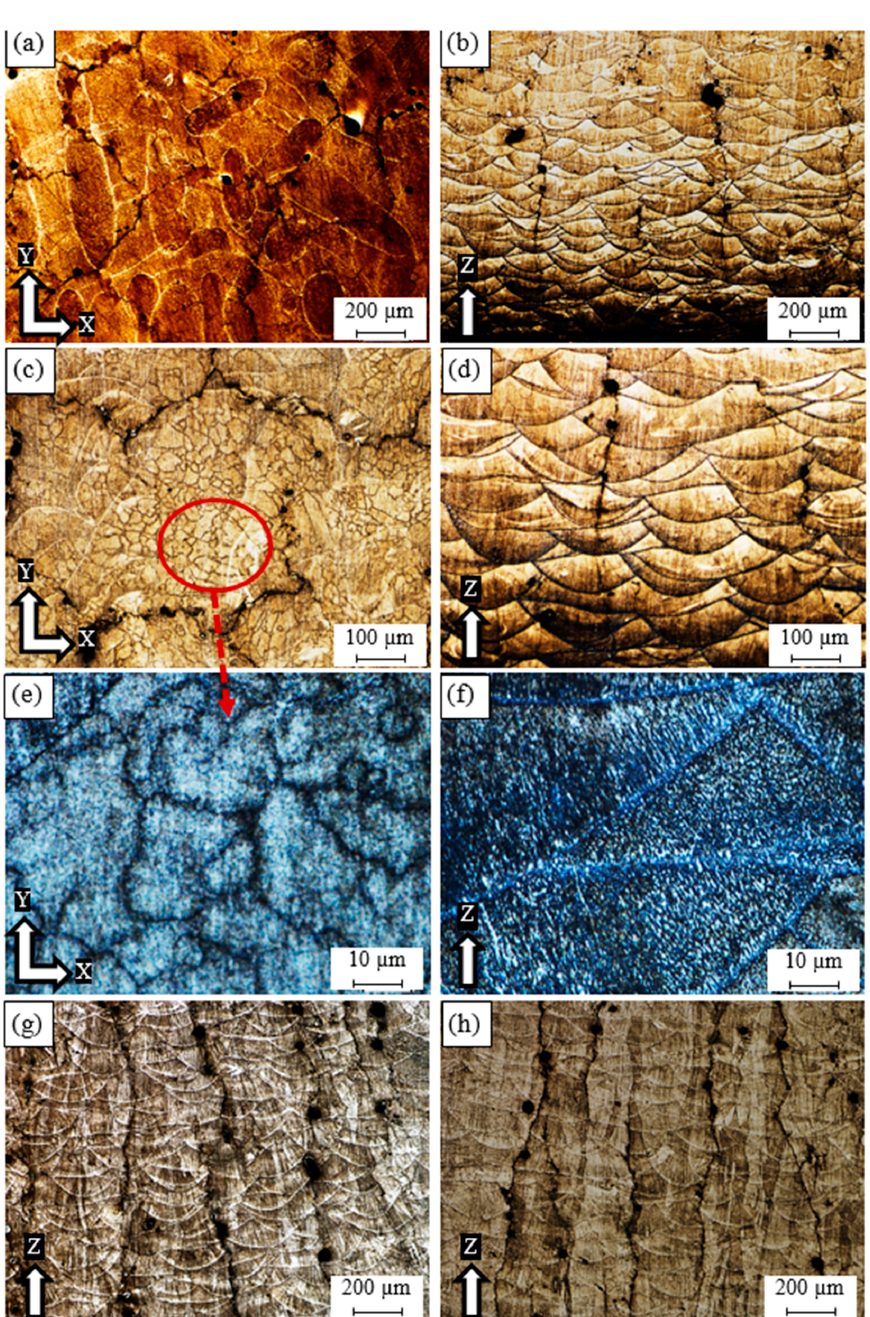
Figure 6. Microstructure of the as-built Al6061 samples processed under different SLM process parameters; ( a , c , e ) 6A along the Z-direction; ( b , d , f ) 6A along the XY plane; ( g ) 14A, and ( h ) 15A.